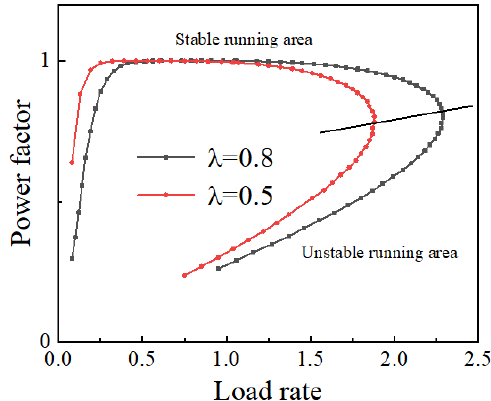
Figure 22. Power factor curves.